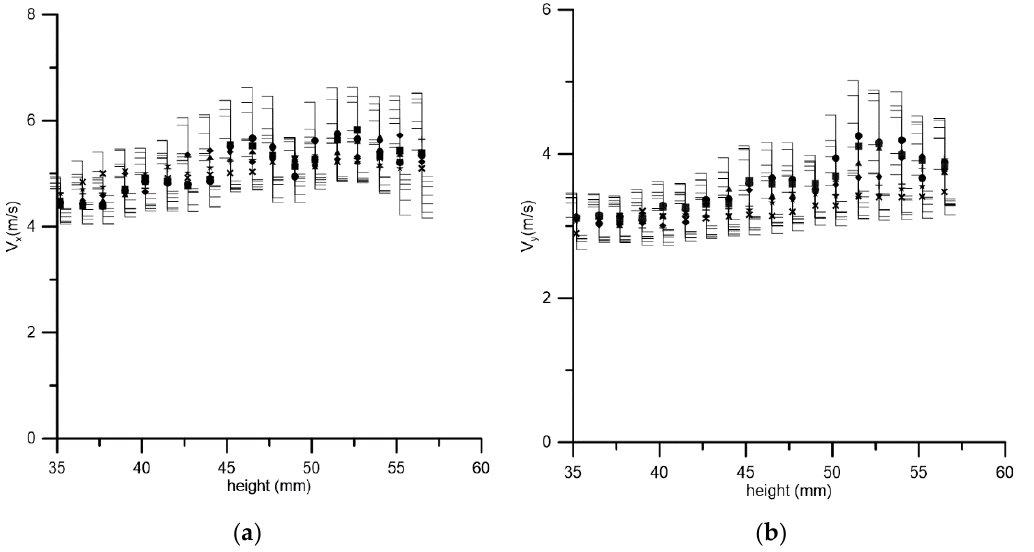
Figure 7. Dependence of the mean value, determined by approximations of the Gaussian distribution function, on the position of the droplet velocity determination region ( a ) for the horizontal component ( b ) of the vertical component. The symbols correspond to different thickness of the observation area: circle—0.6 mm; rectangle—1.3 mm; triangle—3.1 mm; rhombus—6.3 mm; cross—9.4; star—12.5; oblique cross—18.8 mm.